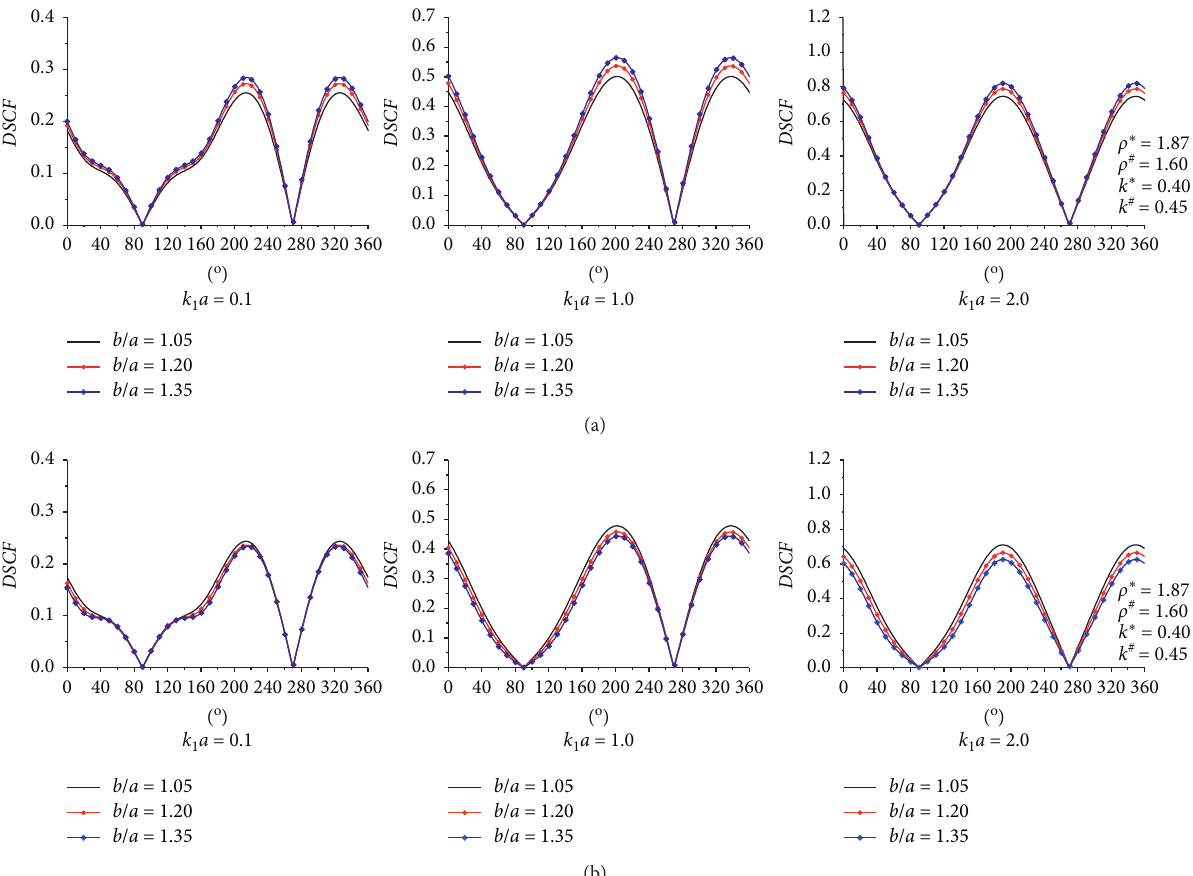
Figure 10: DS CF of linings composed of grade C30 concrete for geological Condition B. (a) Condition B-C30: inner surface. (b) Condition B-C30: outer